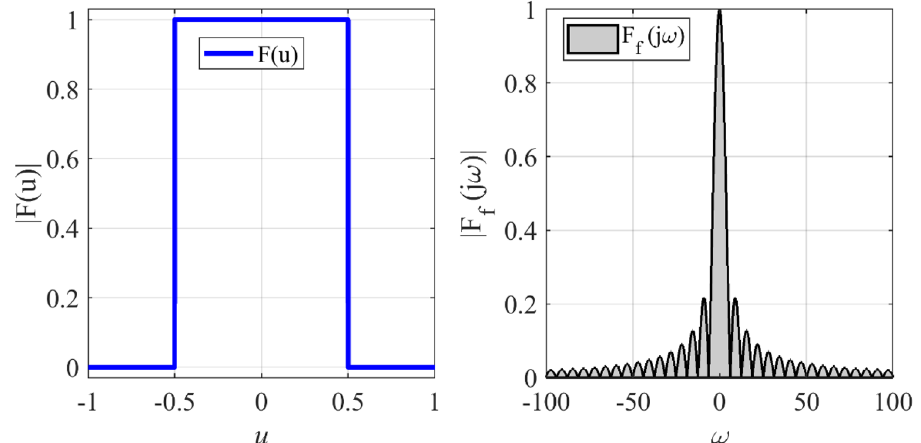
Figure 5. The desired pattern of the second case and its Fourier transform.